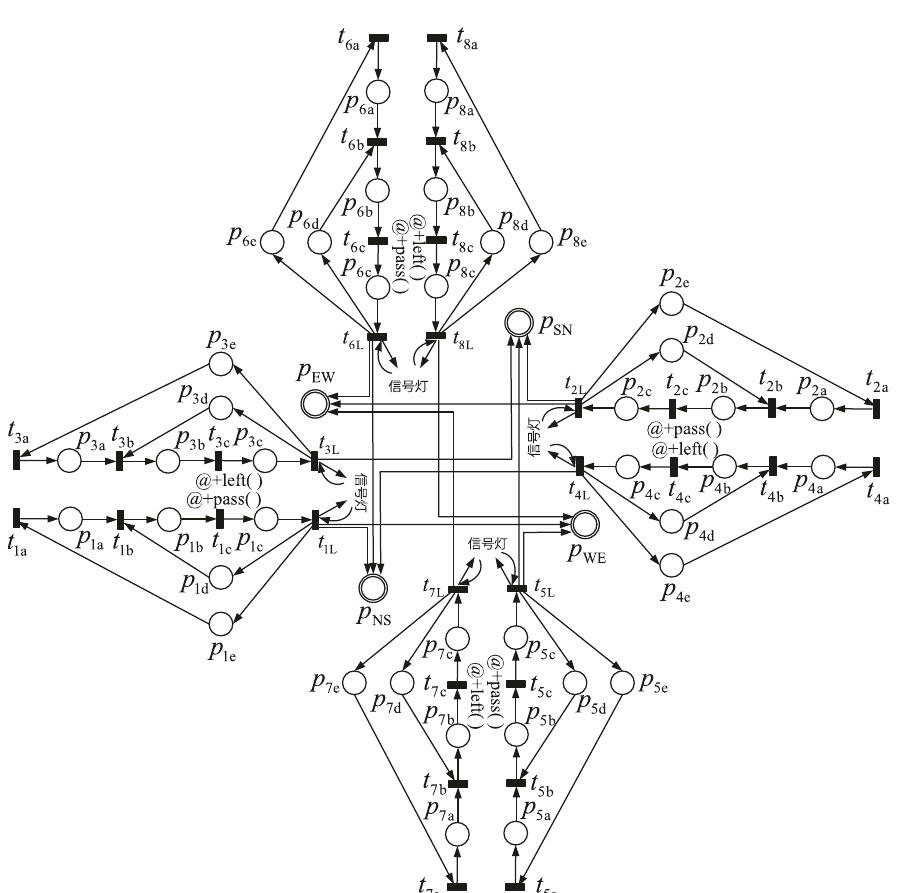
Figure 3: TCPN model of traffic flow at